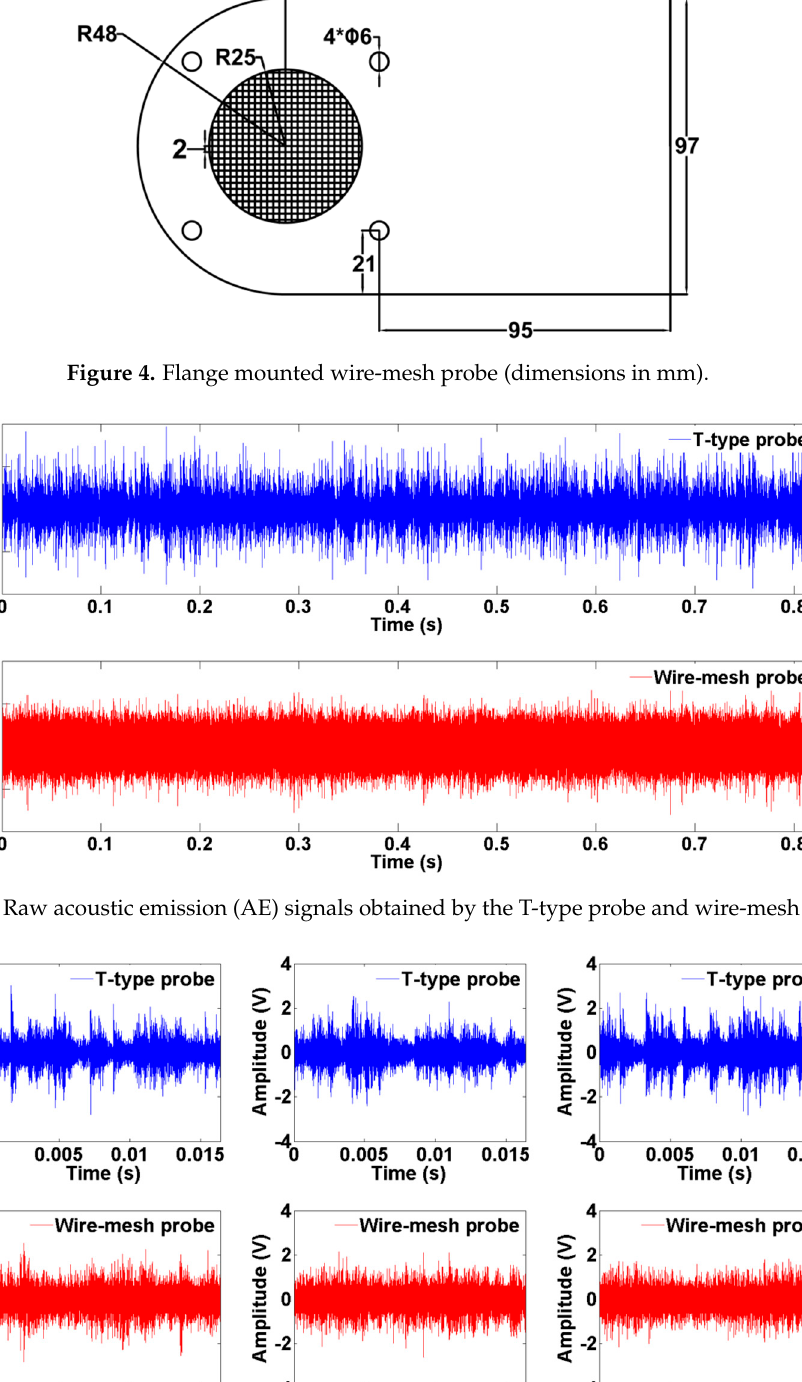
Figure 5. Raw acoustic emission (AE) signals obtained by the T-type probe and wire-mesh probe. Figure 6. Raw AE signals selected at random and divided into Figure 6. Raw AE signals selected at random and divided into samples.